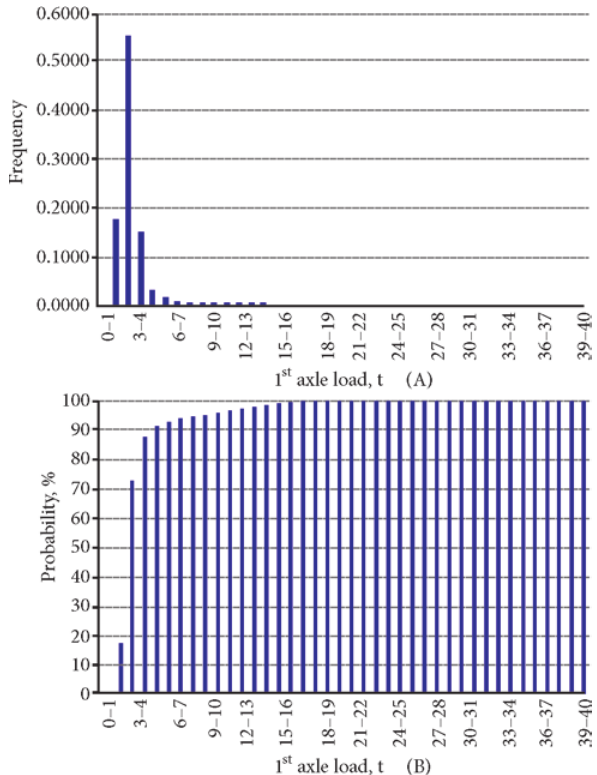
Fig. 4. The 1 st axle load frequency (A) of 2-axle vehicles and the accumulative probability distribution